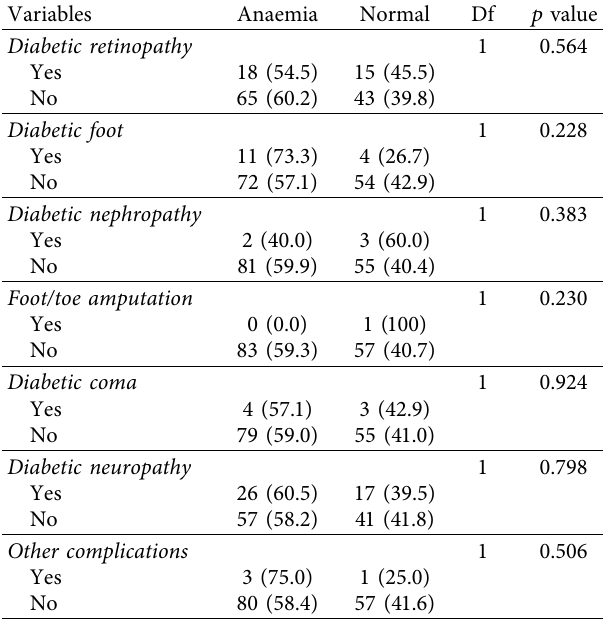
Table 8: History of DM complications among subjects and anaemia.